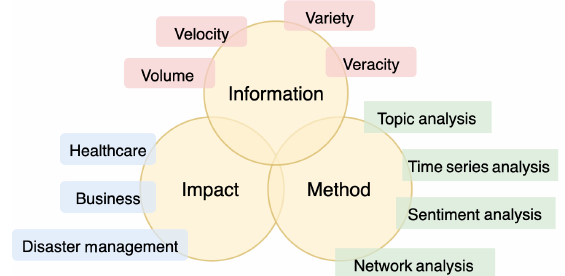
Fig. 4 Four challenges, four analysis techniques, and three impacts of social media-based applications.